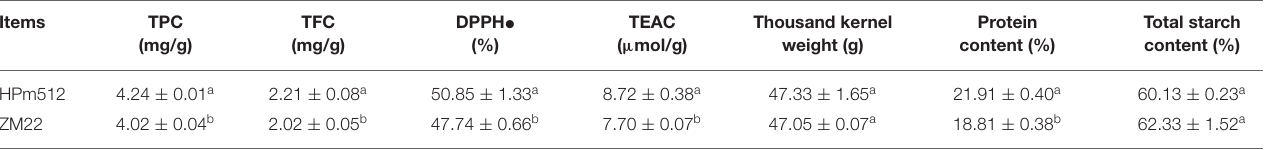
TABLE 1 | Grain characteristics of the two wheat cultivars (lines) HPm512 and ZM22.